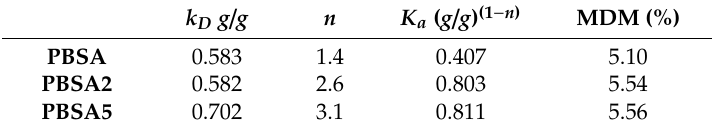
Table 4. Modelling parameters for the neat PBSA and the filled PBSA